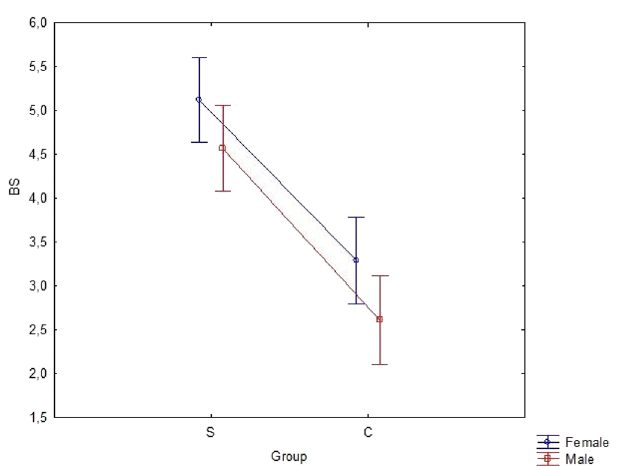
Figure 2. Lack of interaction between constipation and gender in regard to both: study (S) and ontrol (C) group.